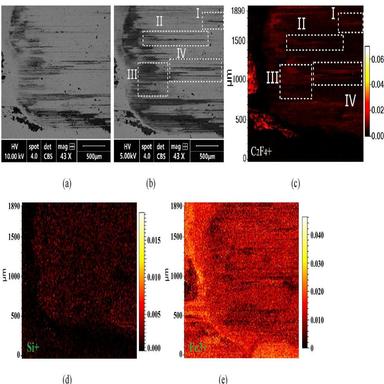
Observation of smooth (non-textured) counter-surface using (a) BSE image (accelerating voltage ¼ 10 keV), (b) BSE image (accelerating voltage ¼ 5 keV), (c) SIMS image of C2F4þ(counts normalized), (d) SIMS image of Siþ(counts normalized), (e) SIMS image of Fe3þ (counts normalized).